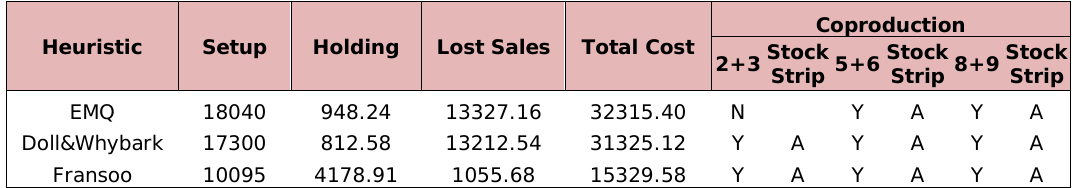
Table 7. “Cost Results of the three scheduling